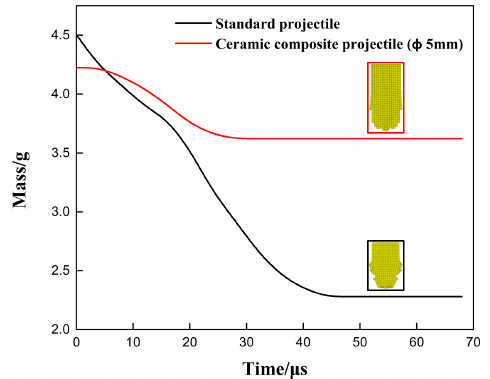
Figure 9. Projectile Core Mass-Time Curve.